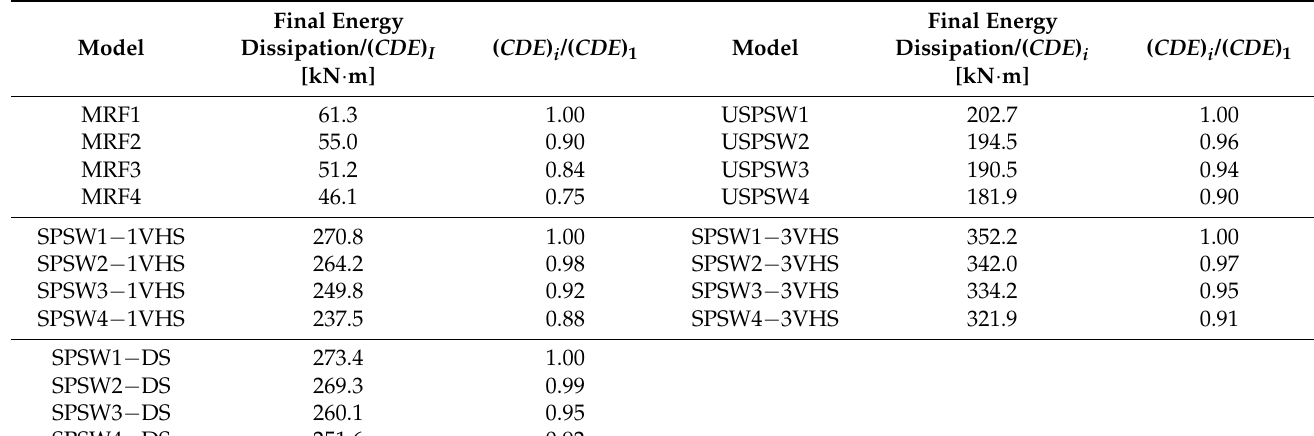
Table 7. Final energy dissipation results for MRF, USPSW, SPSW − 1VHS, SPSW − 3VHS, and SPSW − DS with variable column flexural